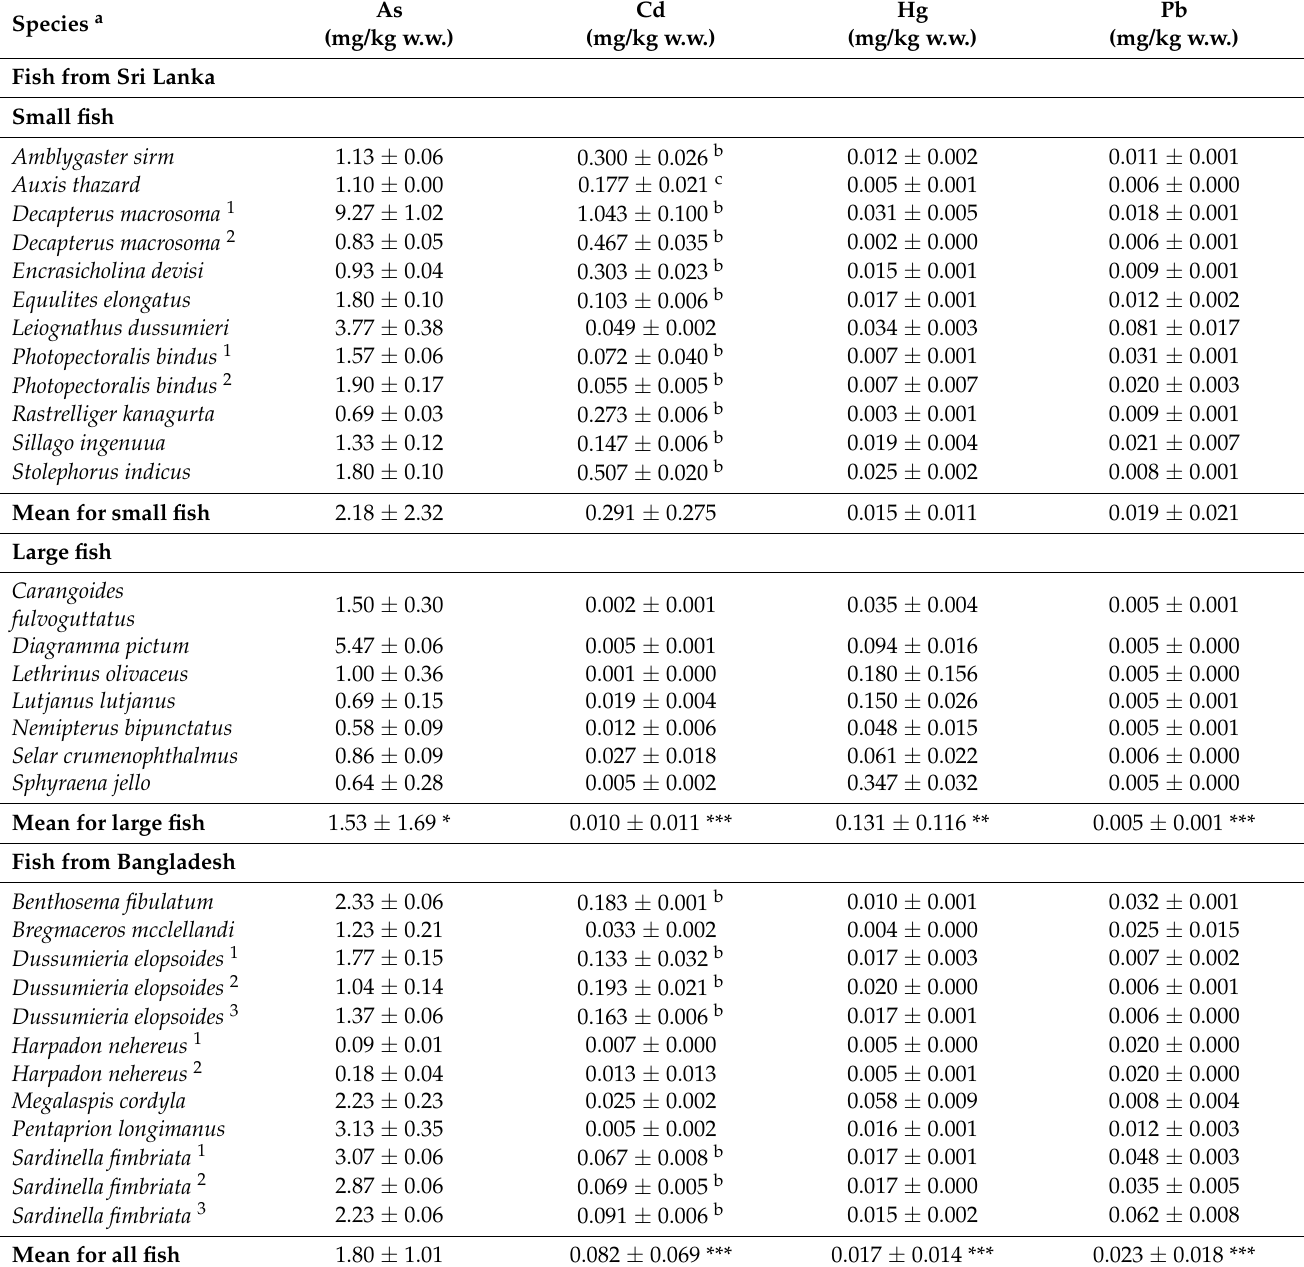
Table 4. Contents of arsenic (As), cadmium (Cd), mercury (Hg), and lead (Pb) in fish species from Sri Lanka and Bangladesh (mean ±